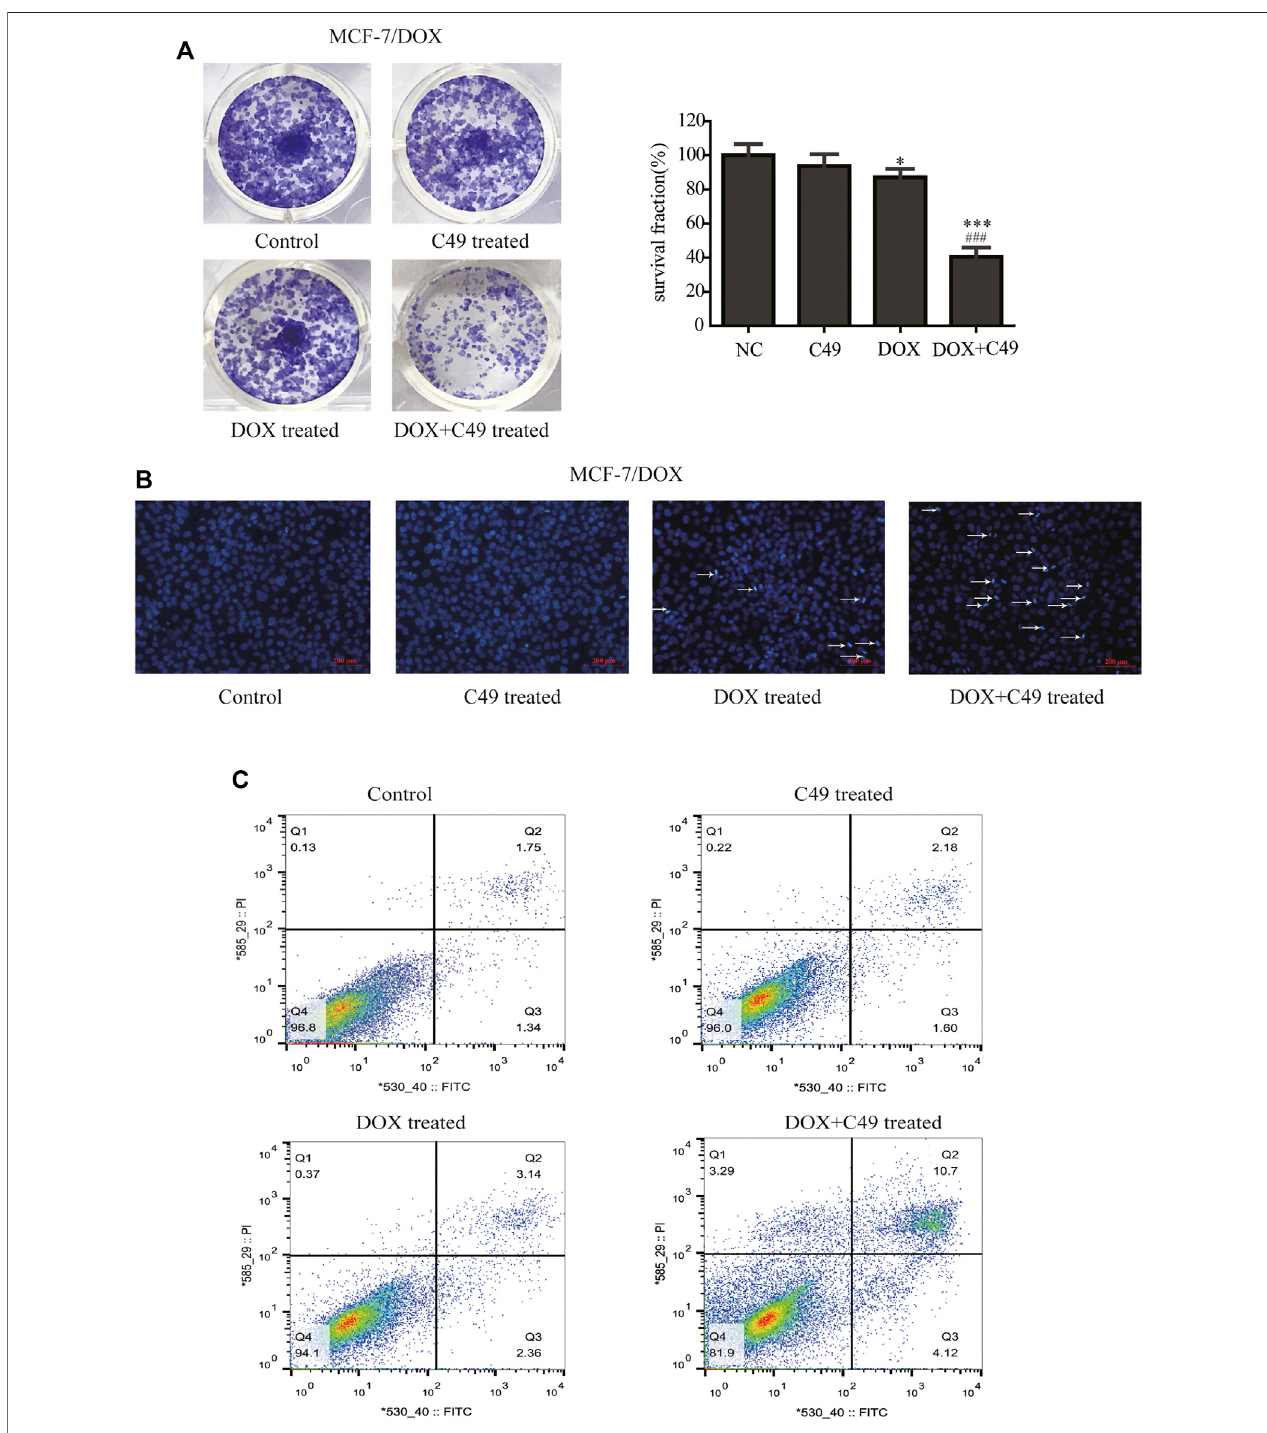
FIGURE 3 | C49 combined with DOX inhibited proliferation and promoted apoptosis of MCF-7/DOX cells. (A) Colony formation showed the proliferation of MCF7/ DOX cells after DOX (8 μ M) and/or C49 (12.5 μ mol/L) treatment. The right panel was the quantitative analysis of colony formation experiment. Each bar represents mean ± SD, n (cid:1) 3. * p < 0.05, ** p < 0.01 and *** p < 0.001 for control cells vs. DOX and/or C49 treated cells. ### p < 0.001 for DOX treated cells vs. combination treated cells. (B) Hoechst33,258stainingshowingnuclearmorphologyofMCF-7/DOXcells24 hafterDOX(8 μ mol/L)and/orC49(12.5 μ M)treatment. (C) Apoptoticcells detected by fl ow cytometry after DOX (8 μ M) and/or C49 (12.5 μ M) treatment for 48 h.